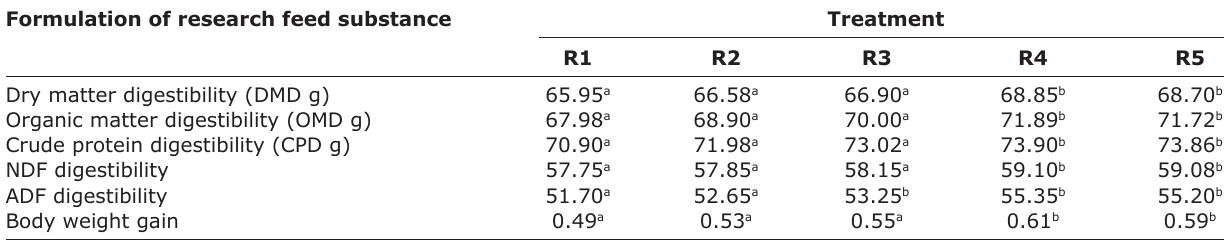
Table-3: Formulation of feed treatment and composition of feed substances. Formulation of research feed